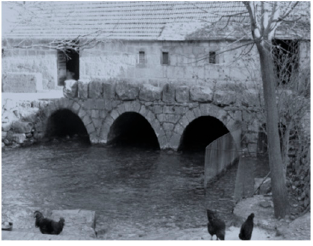
Figure 8. Samar đ i ć mill, Grab (B5). Appl. Sci. 2021 , 11 , x FOR PEER REVIEW 16 of 23 Figure 8. Samar đ i ć mill, Grab (B5). Figure 8. Samar ¯di´c mill, Grab (B5).